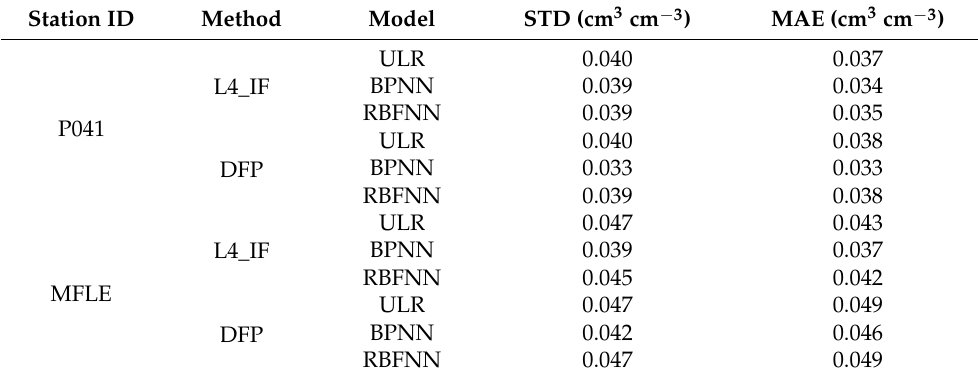
Figure 17. For the MFLE station, comparison between predicted values of three models and measured values of soil moisture ( a ) the L4_IF method; ( b ) the DFP multipath model. Note: The P041_SMC in Figure 16a,b are SMC value of the P041 station; the MFLE_SMC in Figure 17a,b are SMC values of the MFLE station; the ULR_SMC in Figures 16 and 17 are unitary linearity regression model predictive value; the BPNN_SMC in Figures 16 and 17 are back propagation neural network model predictive value; the RBFNN_SMC in Figures 16 and 17 are radial basis function neural network model predictive value. Table 4. Statistical table for precision comparison of three models of L4_IF and DFP methods. Station